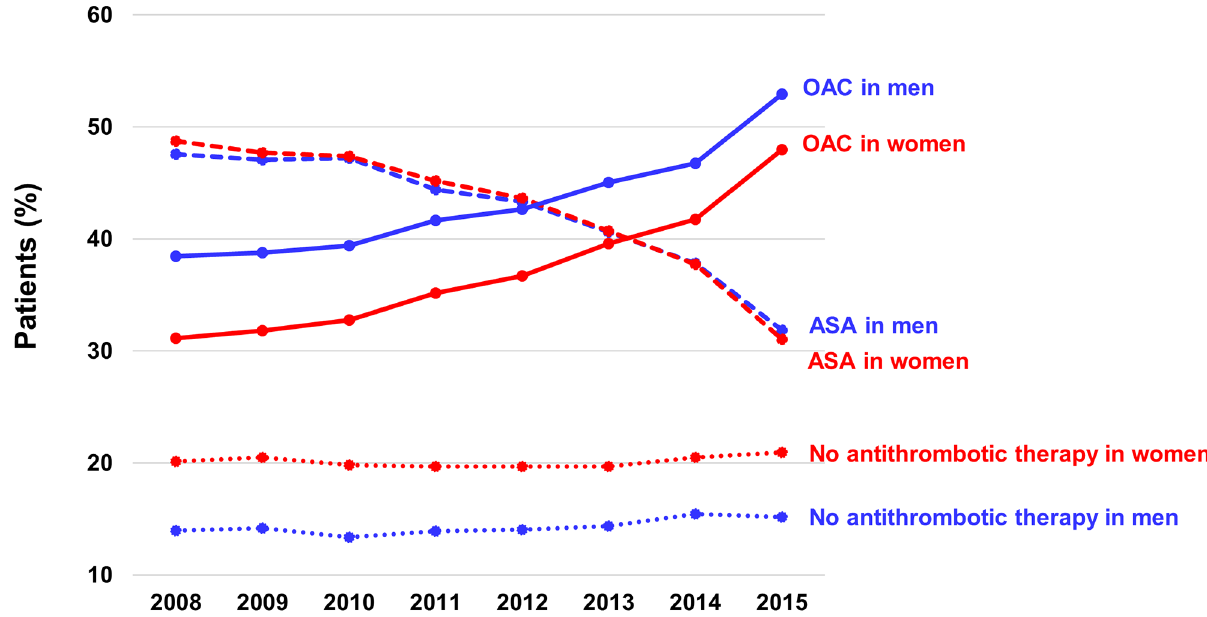
Fig 2. Comparison of temporal trends for each antithrombotic therapy strategy between men and women. Abbreviation: ASA, aspirin; NOAC, non-vitamin K oral anticoagulants.